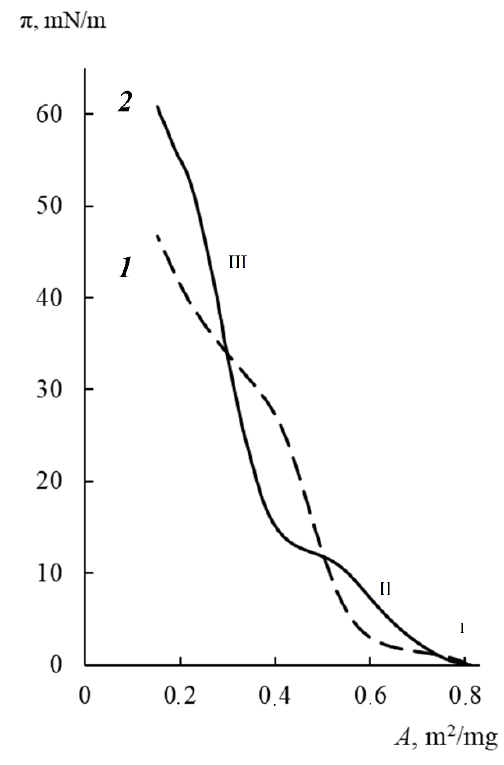
Figure 3. Isotherms of surface pressure π of block copolymer PNIPAAm–Ge(C 6 F 5 ) 2 –PFMA on the subphase at pH = 7.0 (1) and pH = 1.3 (2) spread with chloroform/methanol (volume of spreading solution 30 μ L, T = 21 °C, A —molecular area).